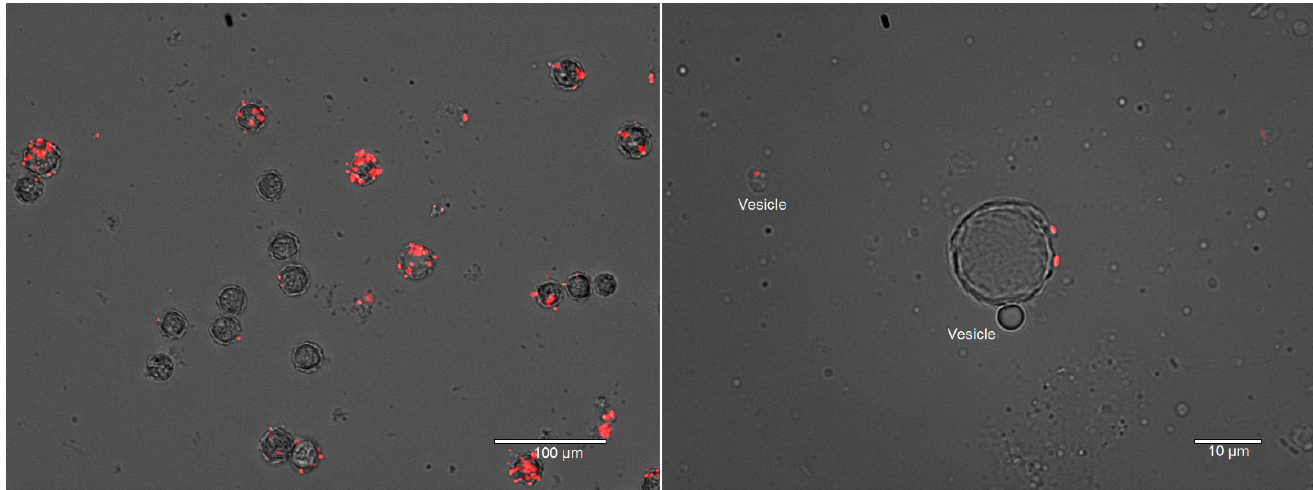
Figure 4. Intracellular locations of E. coli MG1655 (red) in A. polyphaga cysts at 96 h of co-culture. Many of the cysts did not contain any E. coli MG1655 cells, which indicate that the digestion may depend on the intracellular load of the bacterial cells and encystation time. Releasing of vesicle during encystation and vesicle-containing E. coli MG1655 after 48 h of co-culture (Right image).